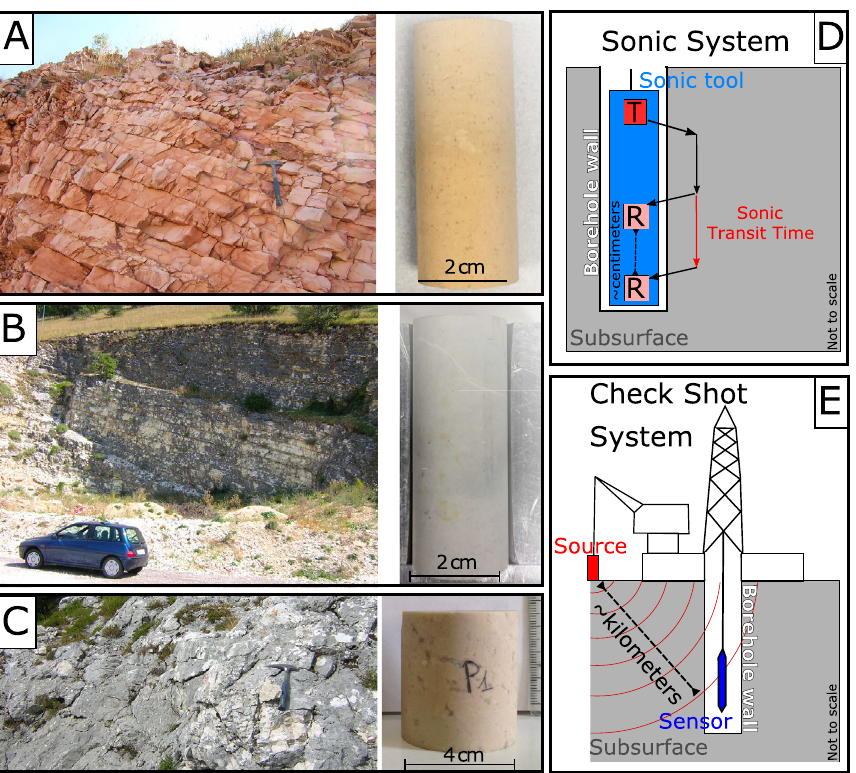
Figure 2. Mesoscale (left side) and small-scale samples (right side) of the analyzed lithologies. ( A ) Massive limestone—Calcare Massiccio (CM), ( B ) Layered limestone—Maiolica (MA) and ( C ) Layered marly limestone—Calcareous Scaglia (CS). ( D ) Sonic System sketch; note that the distance between the transmitter (T) and the two receivers (R) is in the order of centimeters. ( E ) Check shot system sketch; note that the distance between the source and the sensor is in the order of